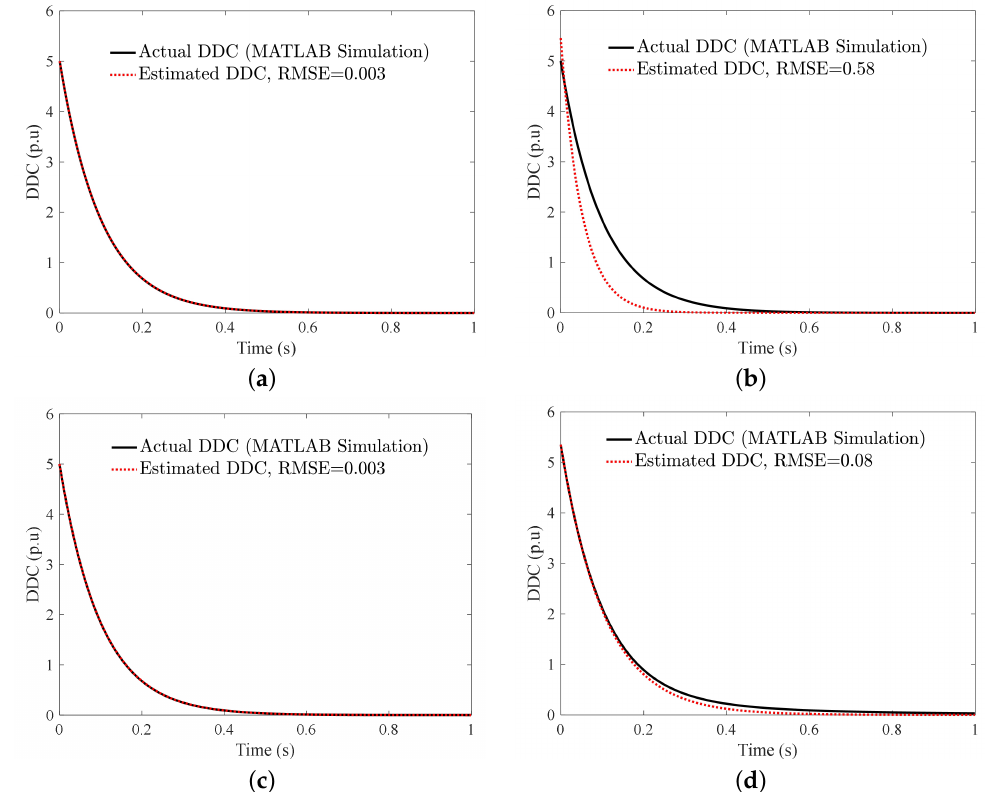
Figure 14. simulation results, method [37] (red line), under four different cases: ( a ) without noise, ( b ) in the presence of noise, ( c ) 0.5 Hz frequency deviation, ( d ) in the presence of the second